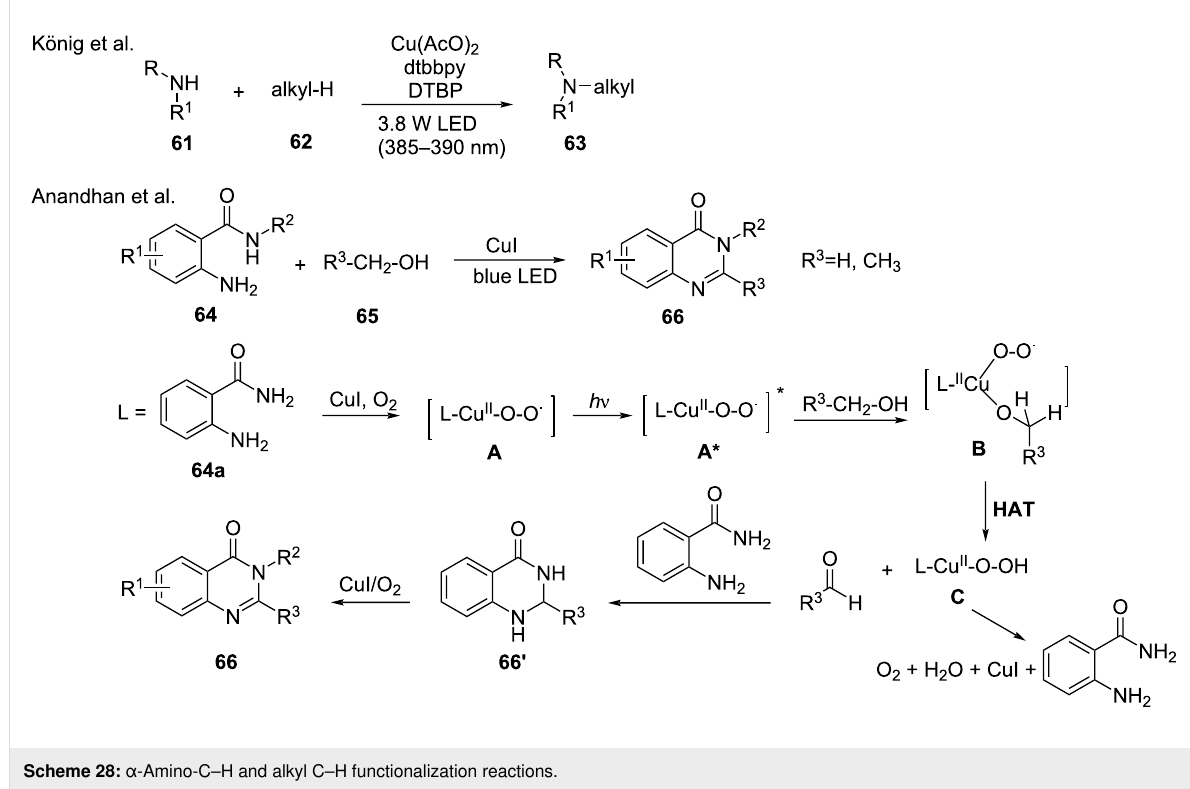
Scheme 28: α -Amino-C–H and alkyl C–H functionalization reactions.